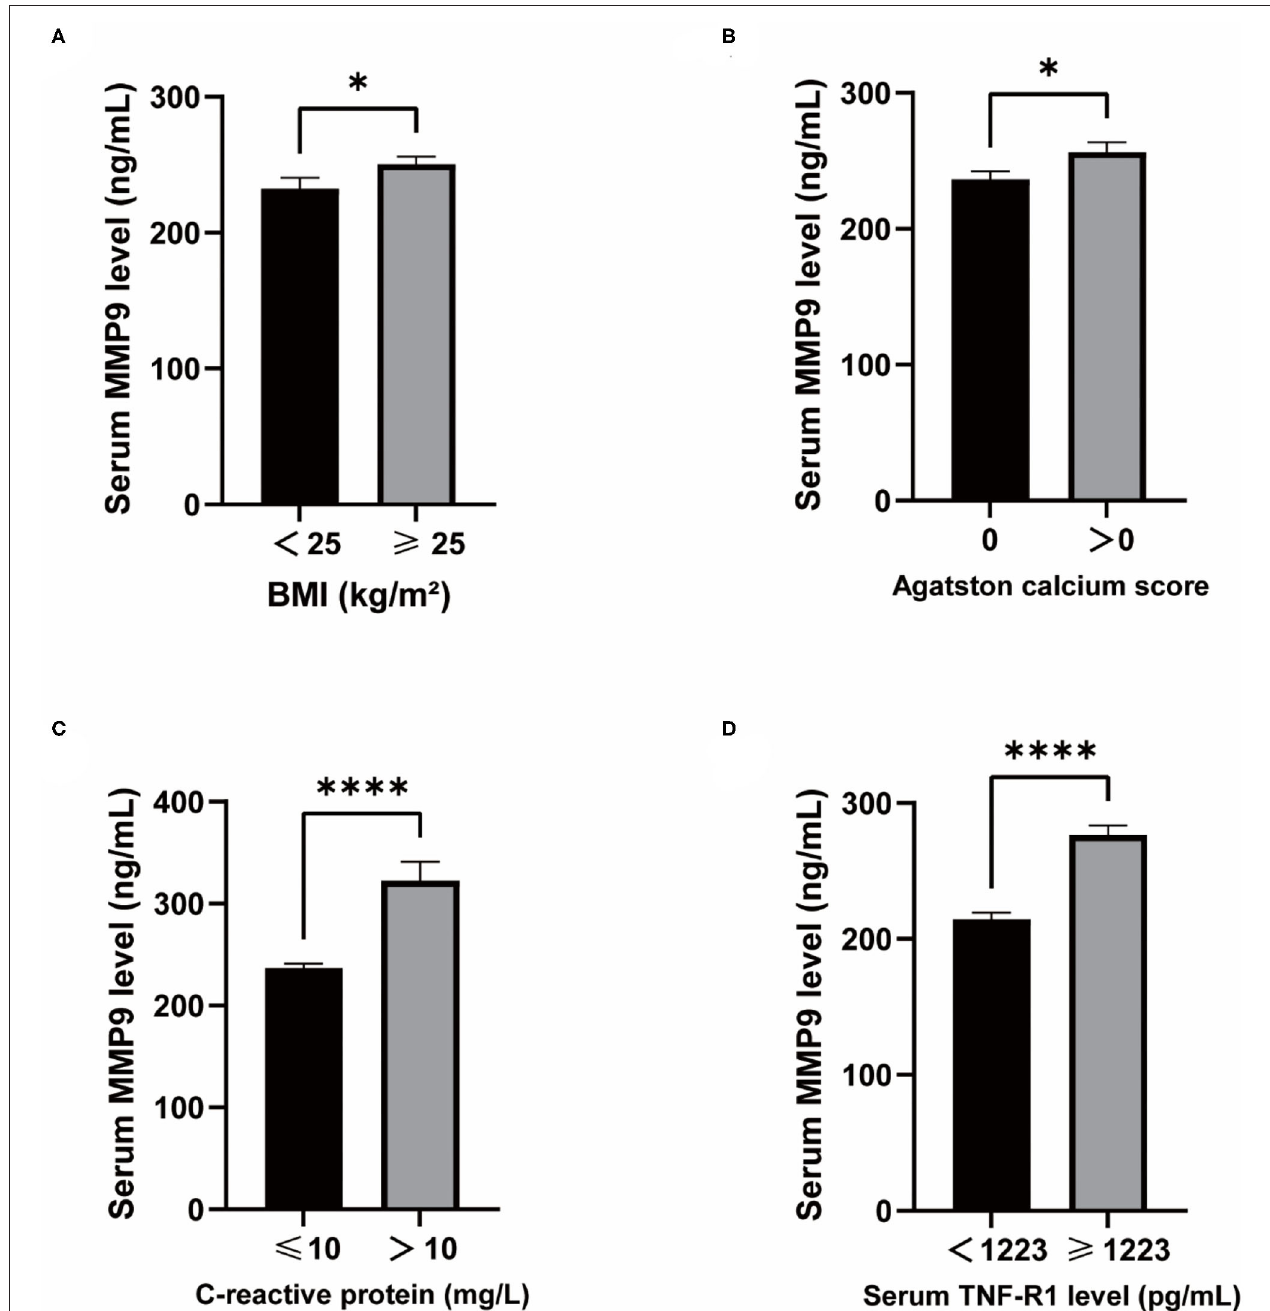
FIGURE 5 | Differences in serum MMP9 levels and clinical physiopathological characteristics. (A) MMP9 levels in BMI ≥ 25 vs. BMI < 25. (B) MMP9 levels in Agatston calcium score = 0 vs. Agatston calcium score > 0. (C) MMP9 levels in CRP ≤ 10 vs. CRP > 10. (D) MMP9 levels in TNF-R1 < 1,223 vs. TNF-R1 ≥ 1,223. * P < 0.05, **** P <